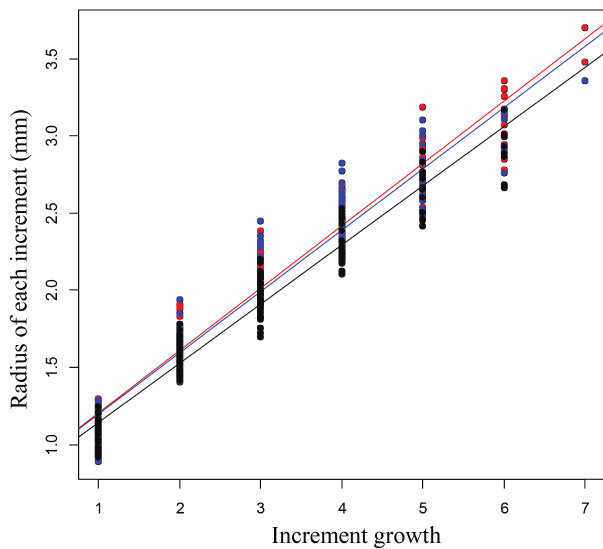
Fig. 6. Regressions between radius of each increments and increments growth estimated in Prochilodus nigricans from Solimões (red), Japurá (blue) and Negro (black) Amazon Basin, Brazil.